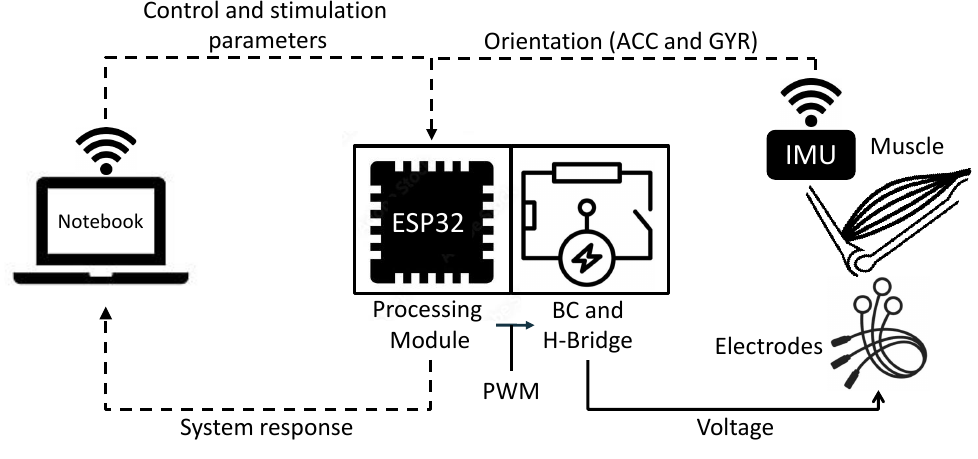
Figure 1. Functional diagram of the proposed